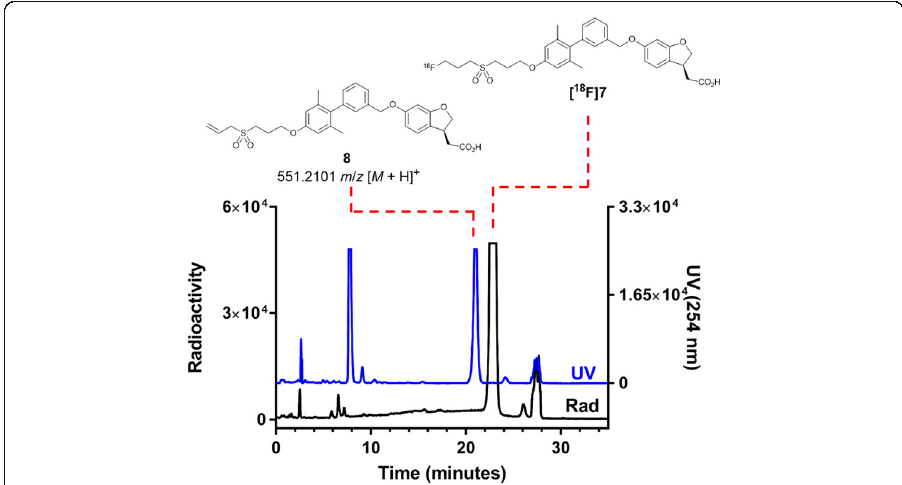
Fig. 1 Semi-preparative HPLC chromatogram of a typical radiosynthesis of [ 18 F]7 . Resolution of [ 18 F]7 (t R = 23 min) from the elimination by-product 8 (t R = 21 min) was achieved using a pentafluorophenyl functionalized HPLC column. Radioactivity (black) and UV ( γ = 254 nm;